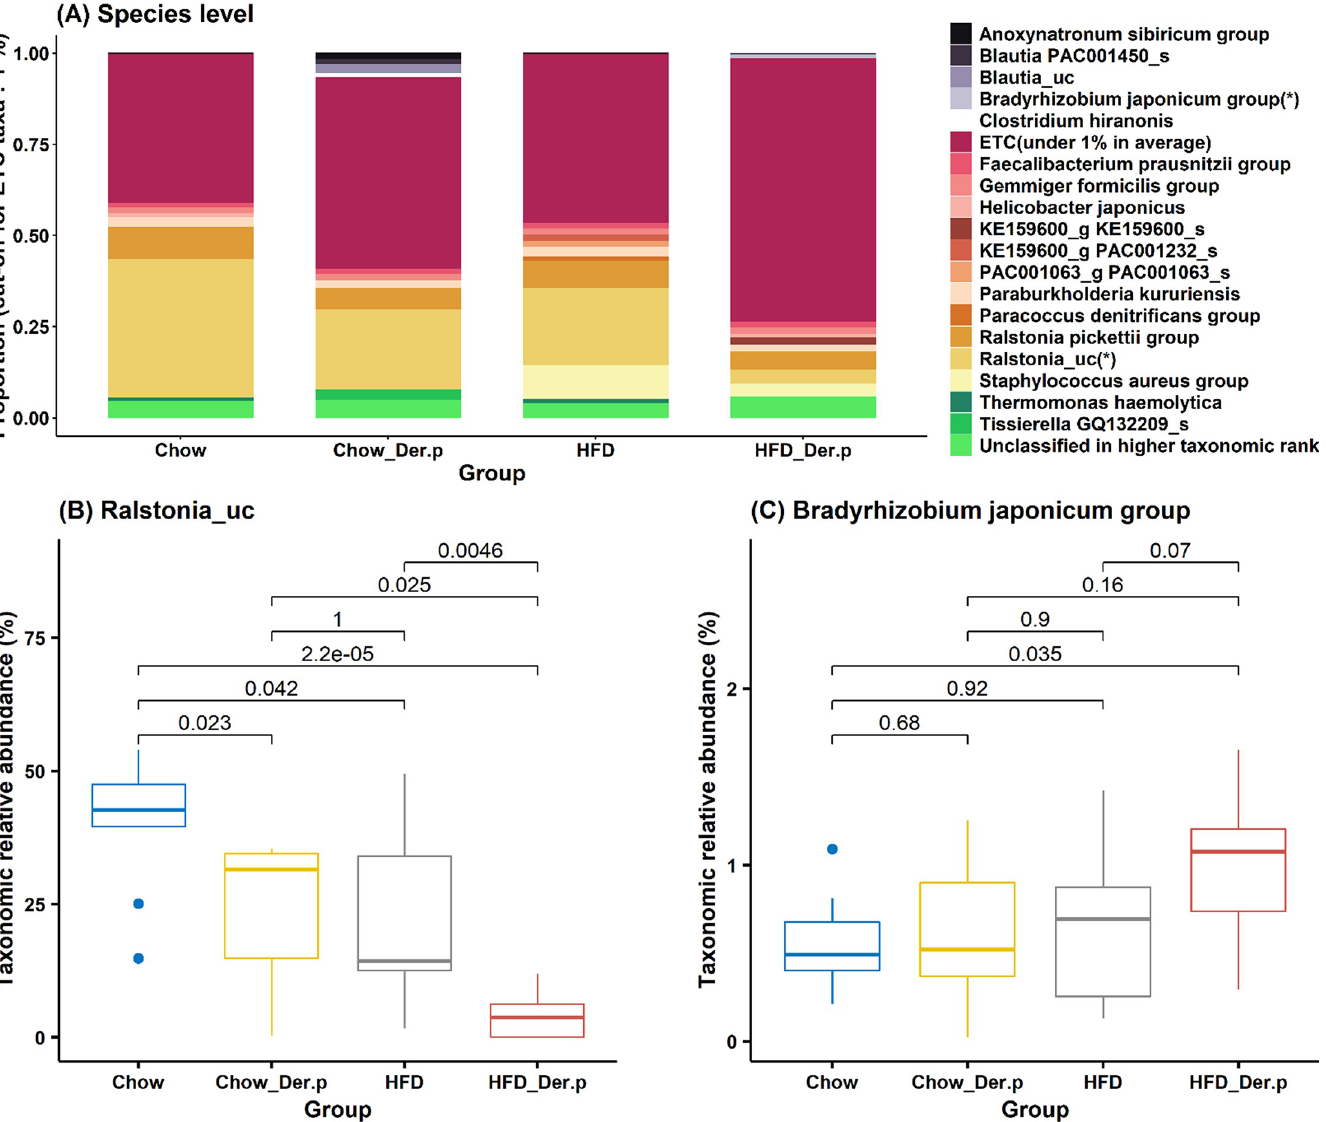
Fig 4. The relative abundances of bacteria at a species level in Chow (n = 9), Chow_Der.p (n = 7), HFD (n = 7), and HFD_Der.p (n = 10) groups. (A) Bar chart of taxonomic proportions at a species level. ETC taxa (under 1% in average) were not considered for comparison between groups. The asterisk ( � ) indicates statistically significant bacteria (Wilcoxon rank-sum test, p < 0.05) for at least one group compared with other groups. Boxplot for the relative abundances of (B) Ralstonia_u c and (C) Bradyrhizobium japonicum group at the species level with p-values (Wilcoxon rank-sum test). The median (line within the box), lower quartiles (Q1), upper quartiles (Q3), non-outlier range (whiskers), and outliers (dot) was described in the